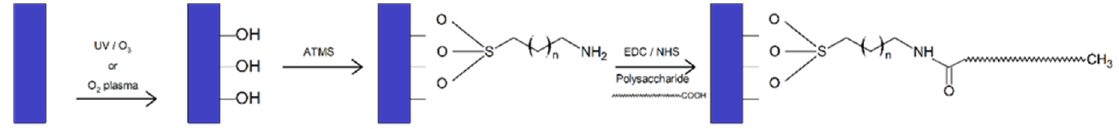
Figure 5. Reaction scheme of the immobilization of polysaccharide. Anti-adhesive surfaces modified by HA, AA, or pectic acid (PA) have been obtained using this method [74]. Surfaces were hydrophilic with a sessile water drop contact angle below or equal to 20° depending on the polysaccharide (AA: 20°; PA: 18°; HA: < 10°). All three polysaccharide surfaces reduced the selement of zoospores of Ulva [75]. HA exhib- ited lower selement and aachment strengths of barnacle Ulva zoospores and barnacle cyprids [75]. However, polysaccharides are capable of binding calcium after immersion in seawater because they carry two carboxyl groups per dimer unit (particularly AA and PA) [75]. Calcium bridging contributes to the decreased resistance versus colonization when antifouling polysaccharides are used in the marine environment since their hydration is reduced [74,75].